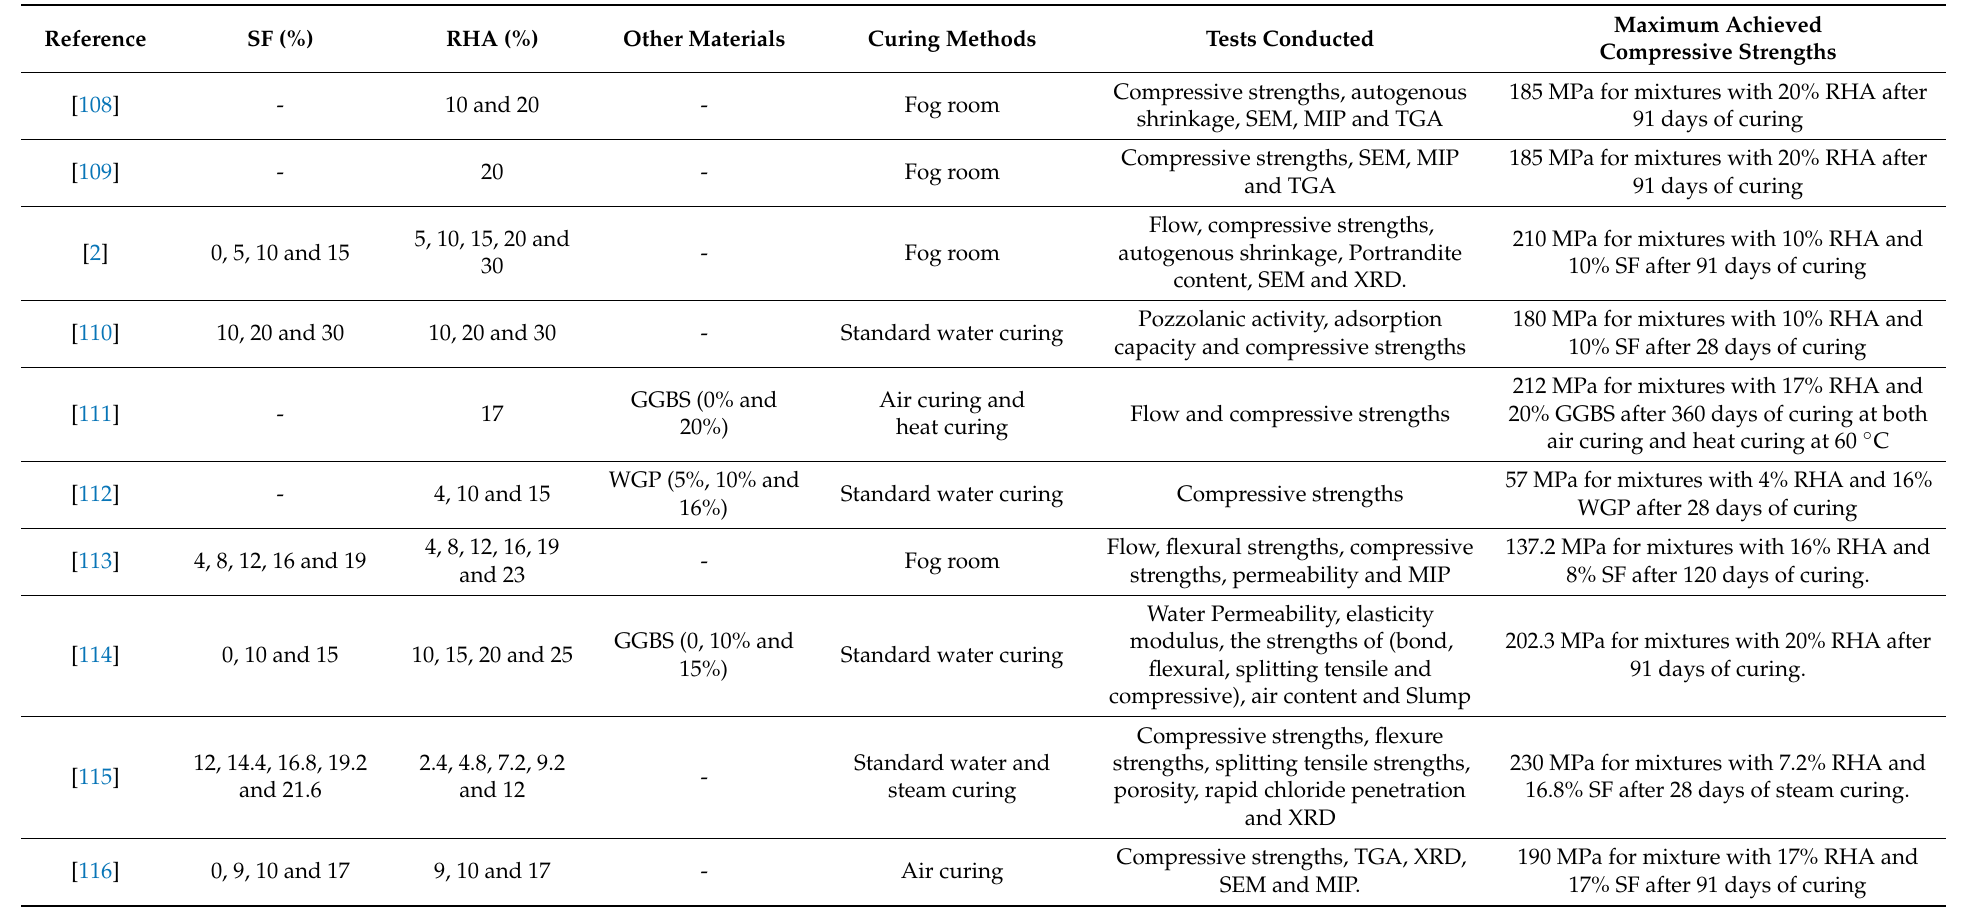
Table 4. Investigates on the utilization of RHA in the production of